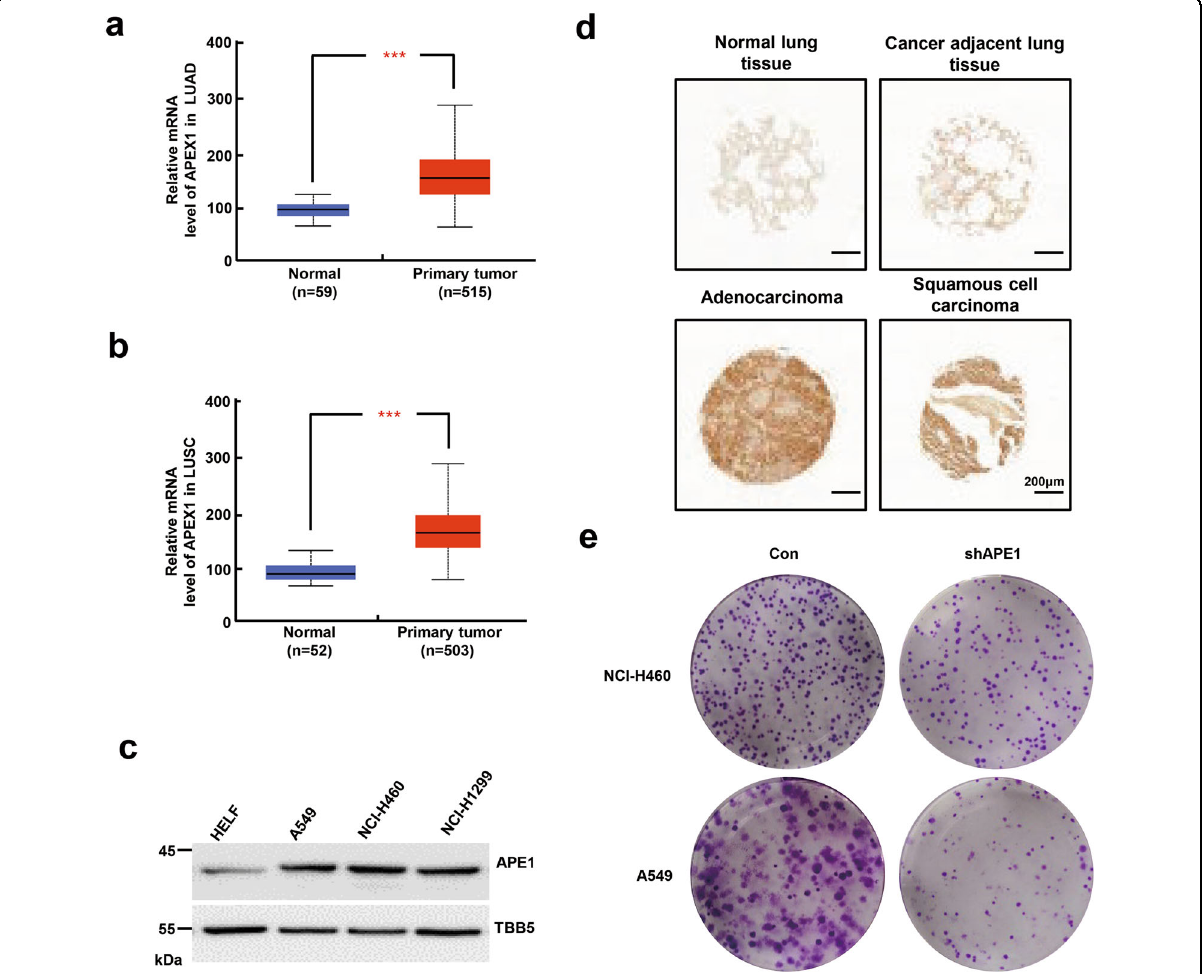
Fig. 1 Expression levels of APE1 are positively correlated with NSCLC. a , b Statistical analysis of APE1 mRNA expression levels in LUAD and LUSC from the TCGA database. c APE1 protein levels in normal lung HELF cell, NSCLC cell lines A549, NCI-H460, and NCI-H1299. d Immunohistochemical staining of APE1 in labeled normal lung tissues or tumor tissues. e Colony-formation assay in control or APE1-KD A549 and NCI-H460 cells. Representative images from one of three experiments are shown. Data are shown as the mean ± SD of three independent experiments. *** p <